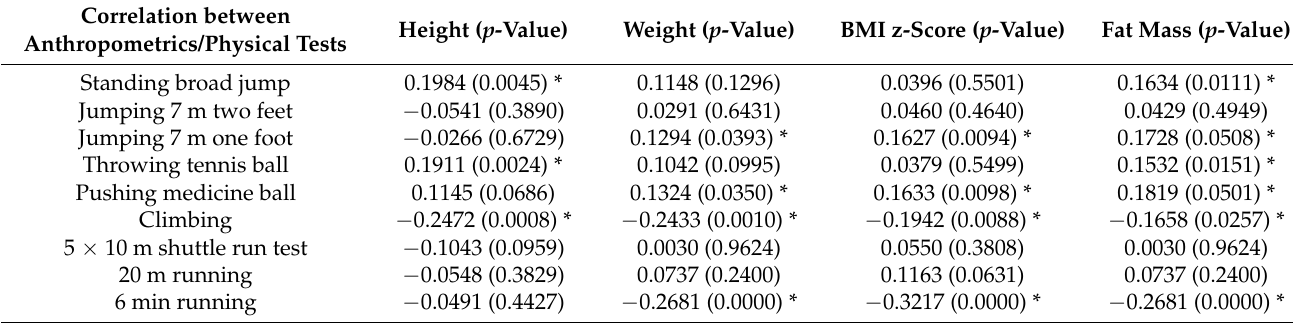
Table 5. Correlation between anthropometrics characteristics and physical fitness